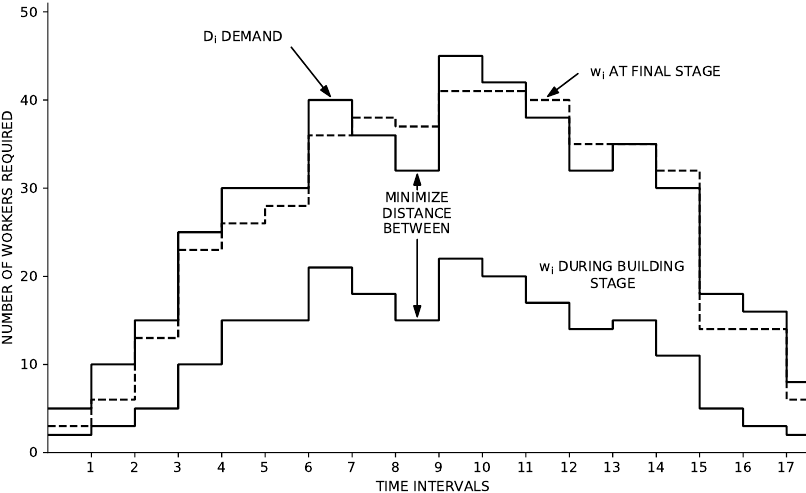
Figure 1. An example of a work shift scheduling